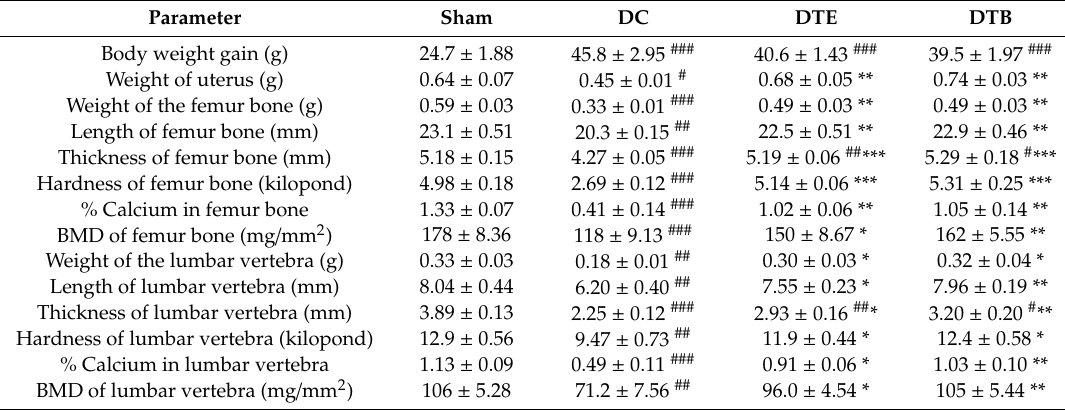
Table 1. E ff ect of acetyl-11-keto- β -boswellic acid (AKBA) on physical parameters in ovariectomized